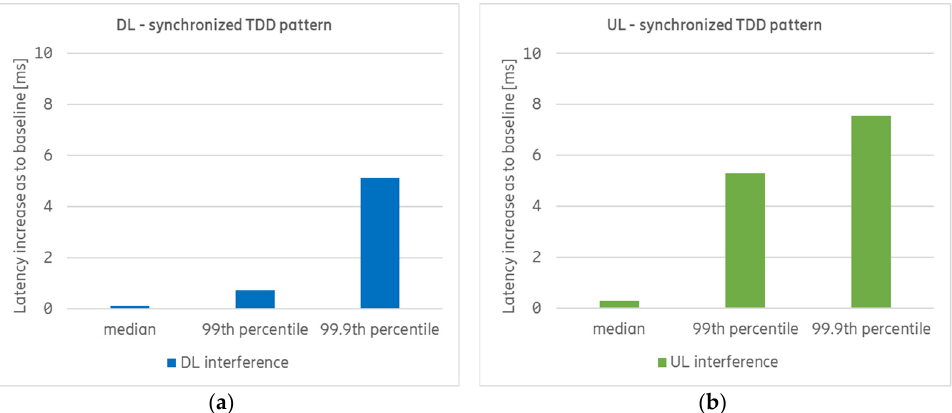
Figure 3. Increase in DL ( a ) and UL ( b ) latency compared to their respective baselines for synchro- nized TDD pattern (DDDDU) used by the indoor and outdoor networks. TDD pattern (DDDDU) used by the indoor and outdoor